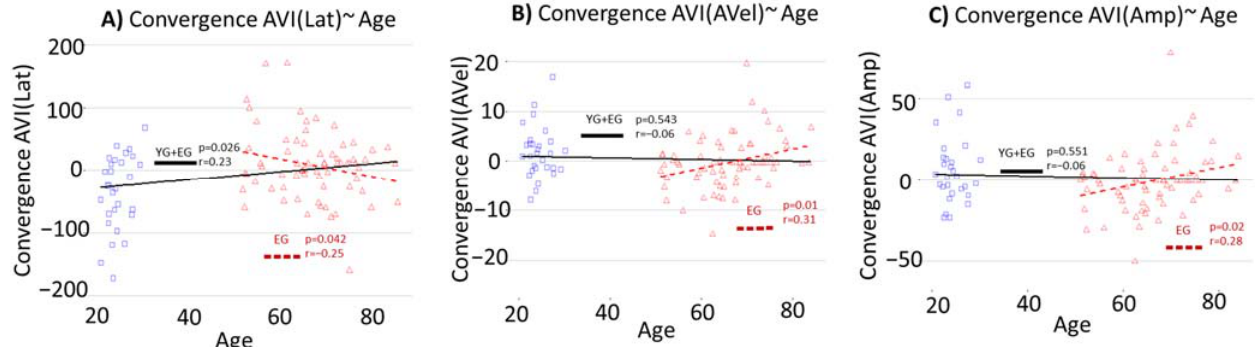
Figure 3. Correlations and regression lines between convergence AVI and age, for ( A ) AVI(Lat), ( B ) AVI(AVel), and ( C ) AVI(Amp), regarding the whole population (young and elderly groups) and elderly group alone. Blue squares represent the young participants; red triangles represent the elderly participants. The black solid line represents the regression line for the whole population and the red dashed line represents the regression line for the elderly group. “r” represents the Pearson correlation coefficient and “ p ” represents the significance of the slopes of the regression line.